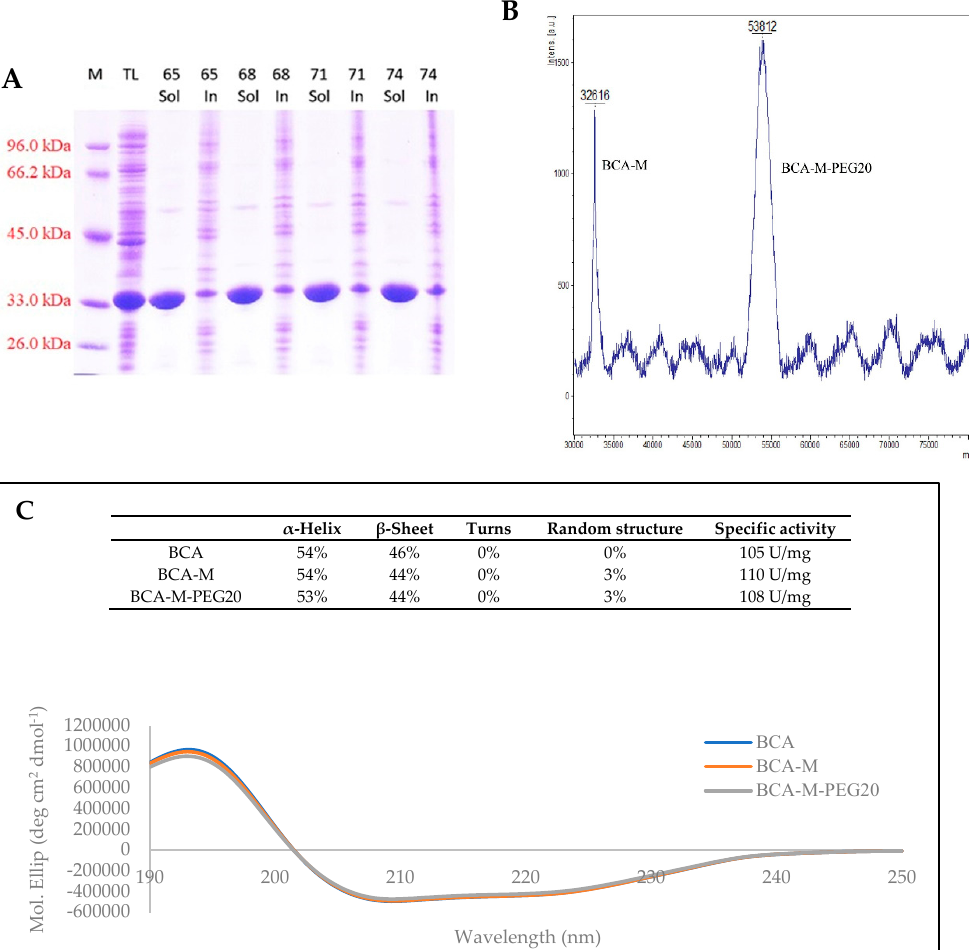
Figure 4. Characterization of BCA, BCA-M and BCA-M-PEG20. ( A ) BCA-M purification by heat treatment, from 65 to 74 ◦ C. M = marker; TL = total lysate; Sol = soluble fraction; In = insoluble fraction. ( B ) MALDI-TOF-MS spectrum of BCA-M-PEG20 (expected molecular weight = 32.45 kDa). ( C ) Circular dichroism (CD) spectra and specific activities of BCA, BCA-M and BCA-M-PEG20.